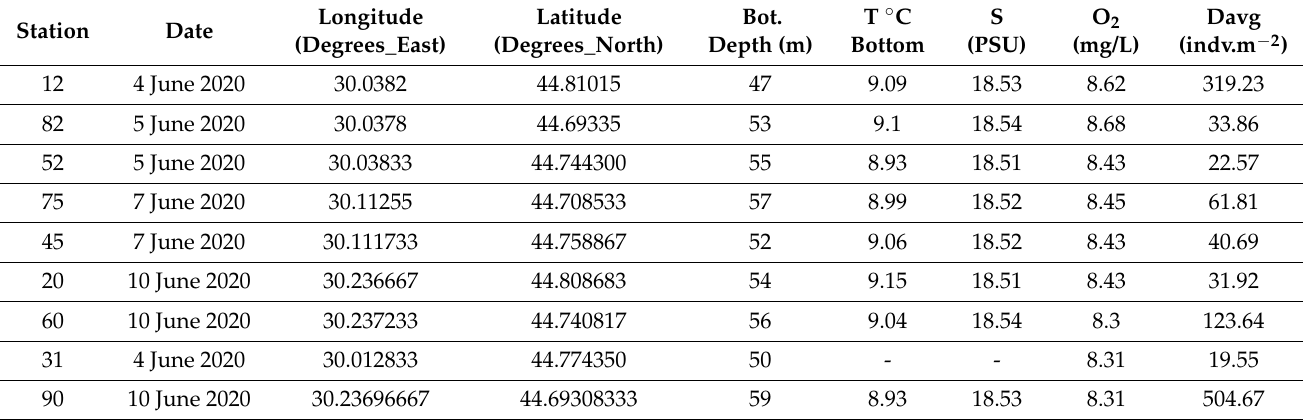
Table 2. Details on the location of sampling stations, average density of Pseudochromadora gomoi sp.n. (given as numbers of individuals in a square meter) (average densities are square root transformed) and environmental